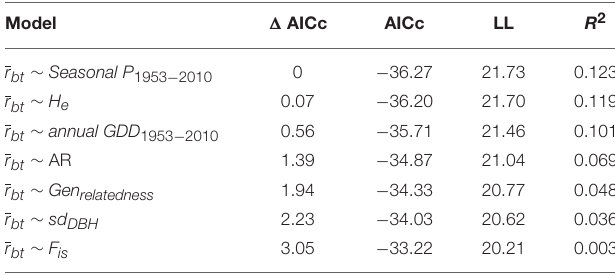
TABLE 2 | Results of the linear model selection explaining the radial growth synchronicity between trees in a given site ( r b t ). Model 1 AICc AICc LL R 2